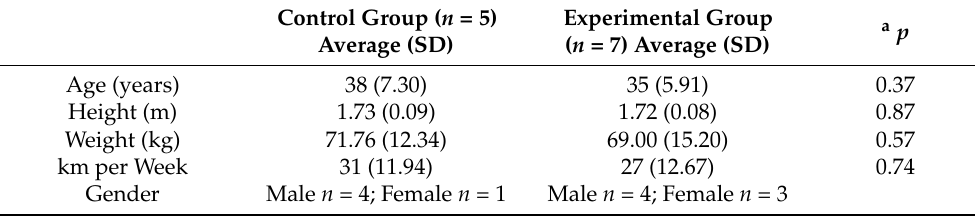
Table 1. Participants’